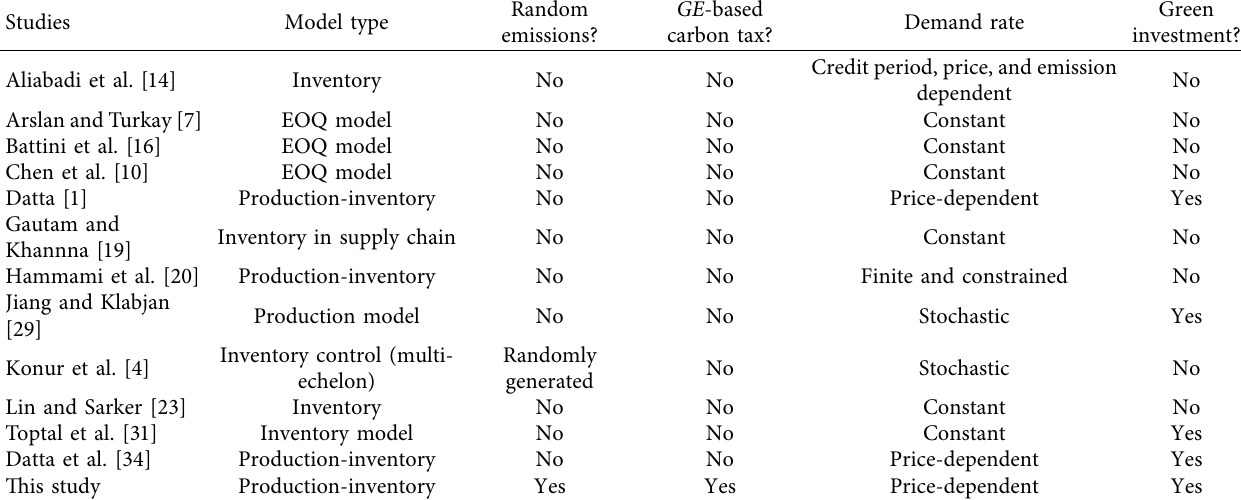
Table 1: Comparison of the present study with other related